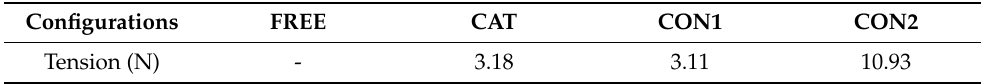
Table 4. Mean cable tensions in the buoy’s rest position.